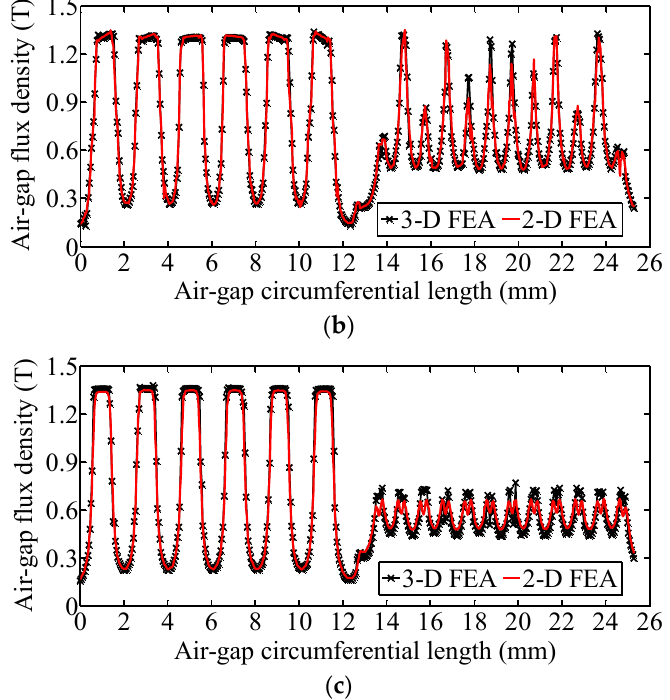
Figure 12. Comparison of air-gap PM flux density of sub-motor1 after tooth-layer variation. ( a ) g = 0.1 mm, w t = 0.8 mm, t ps = 6.9°; ( b ) g = 0.2 mm, w t = 1.0 mm, t ps = 6.9°; ( c ) g = 0.2 mm, w t = 0.8 mm, t ps = 7.2°.